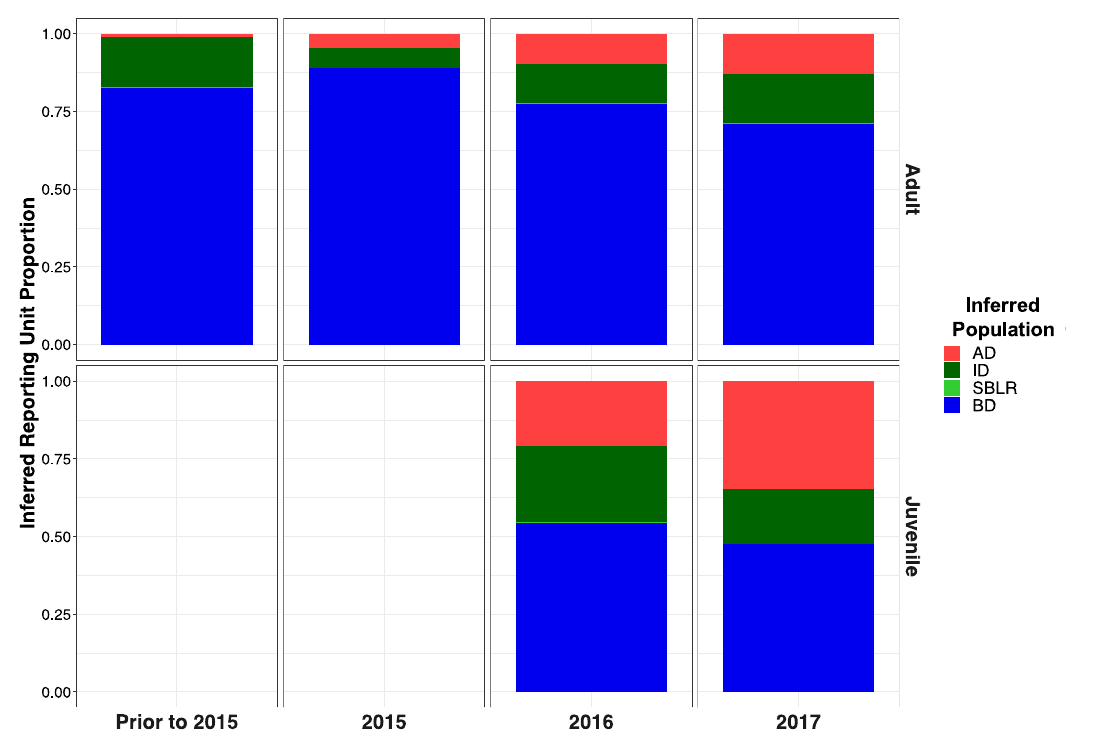
Modified Figure A1: Updated following correction to metadata.